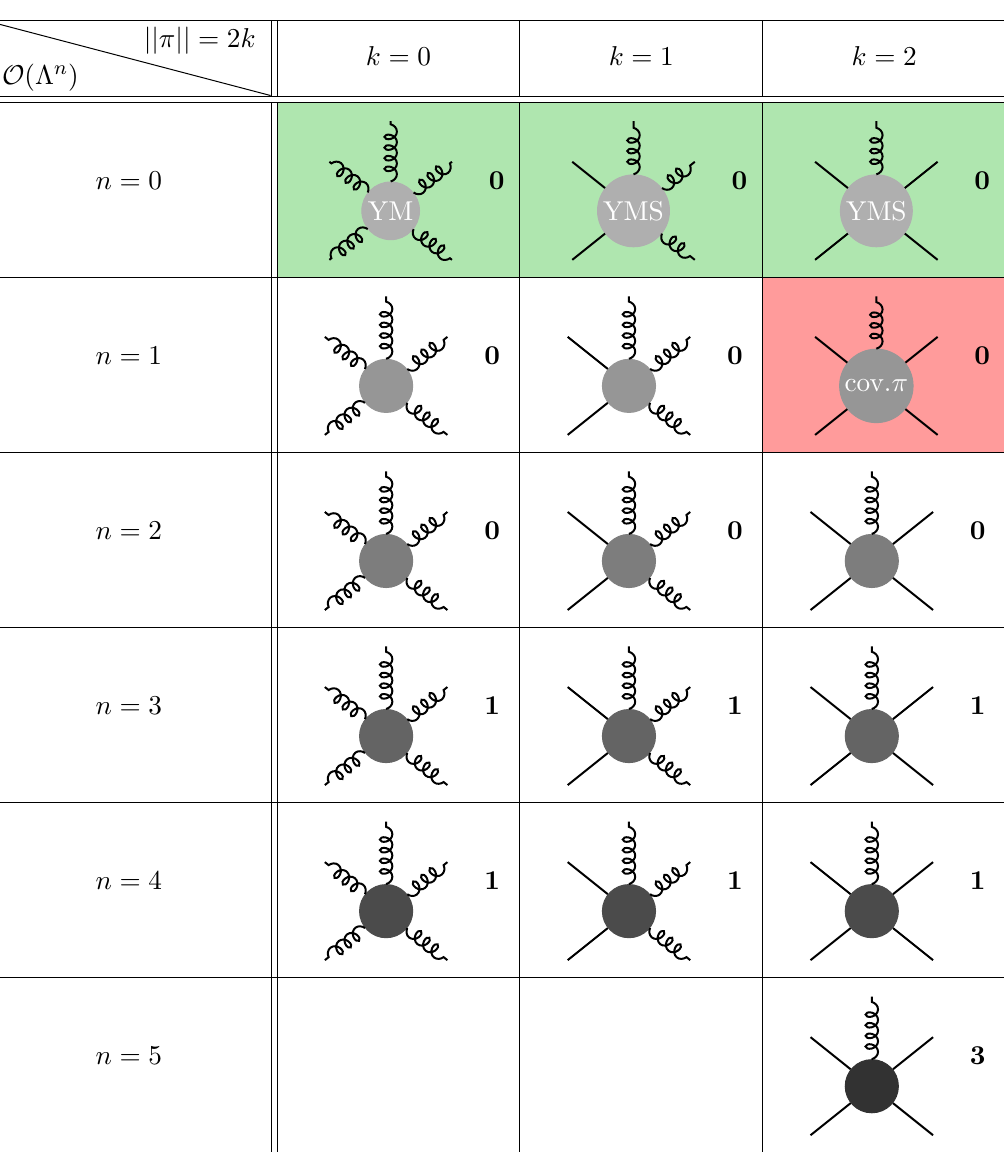
Table 3 . Five-point amplitudes for k pairs of pions — Green cells contain amplitudes generated by eq. (3.1). The amplitude highlighted in red violated BCJ relations when only considering in- teractions of eq. (3.1). This amplitude, A cov. π , needed additional interactions in eq. (3.8) to be double-copy